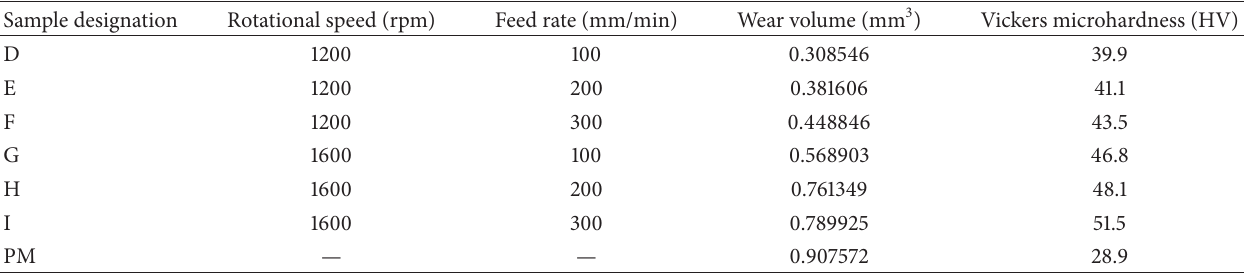
Table 3: Wear volume and microhardness results.